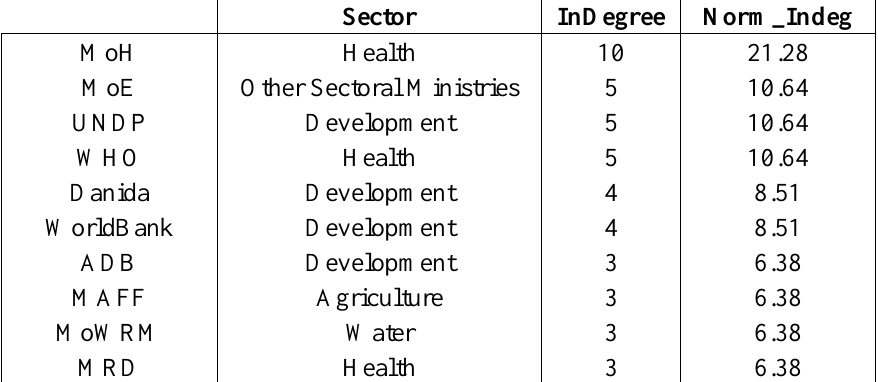
Table 2. Health and climate change partnerships in Cambodia: Top10 most prominent